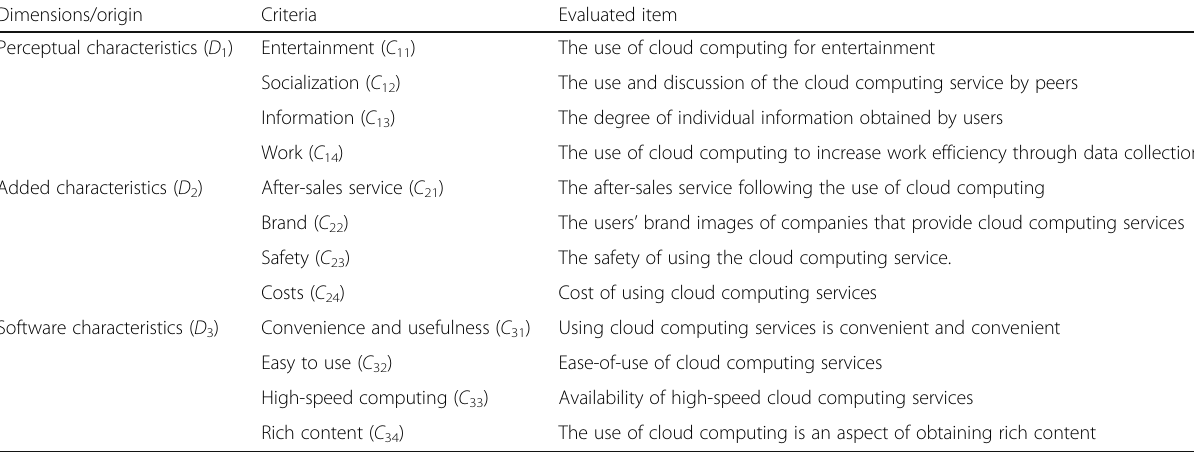
Table 1 The dimensions and criteria associated with cloud service applications